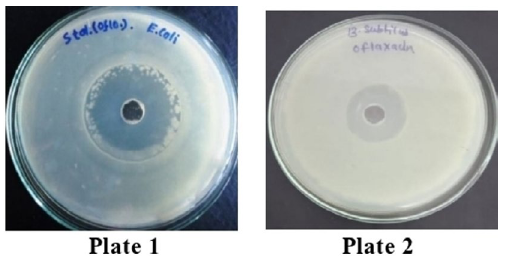
Fig. 5. Plate 3& 4. Anti-Bacterial Activity of Ofloxacin against S. aureus and S.